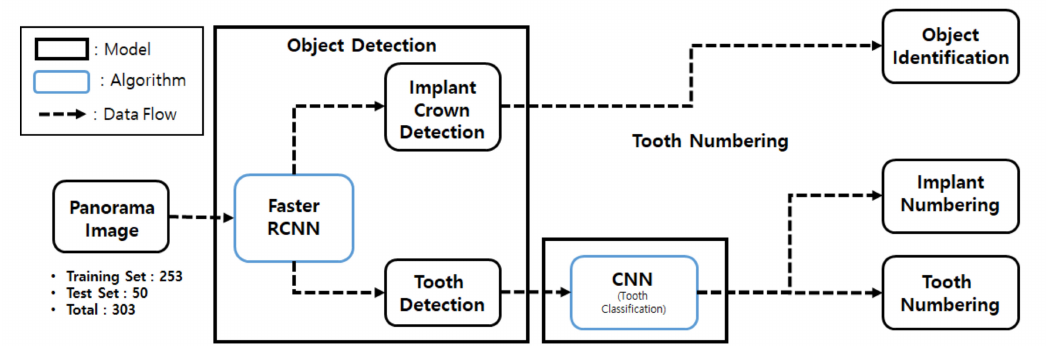
Figure 3. Algorithm for object detection and tooth numbering.